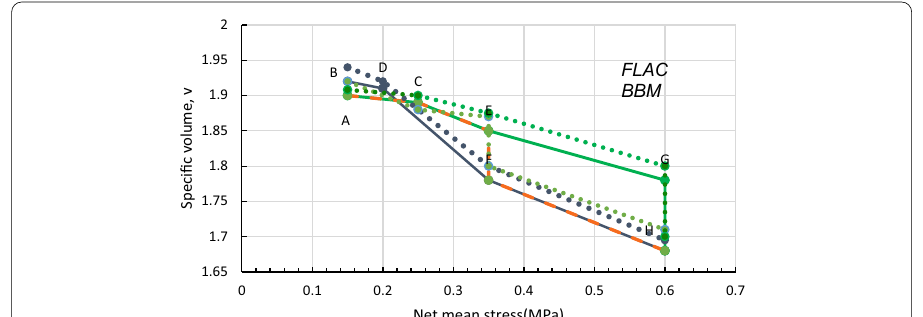
Fig. 4 Comparison of FLAC prediction and BBM analytical results in the stress paths